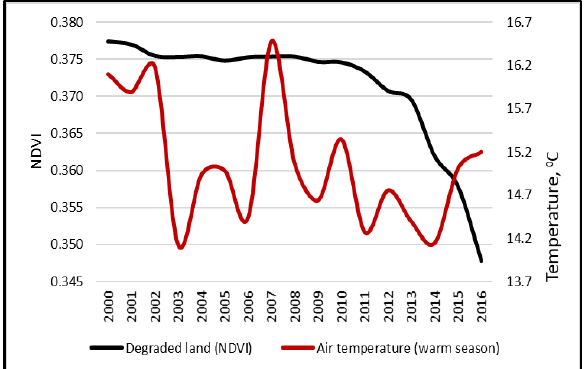
Figure 5a. The temporal variation between degraded land and air temperature.